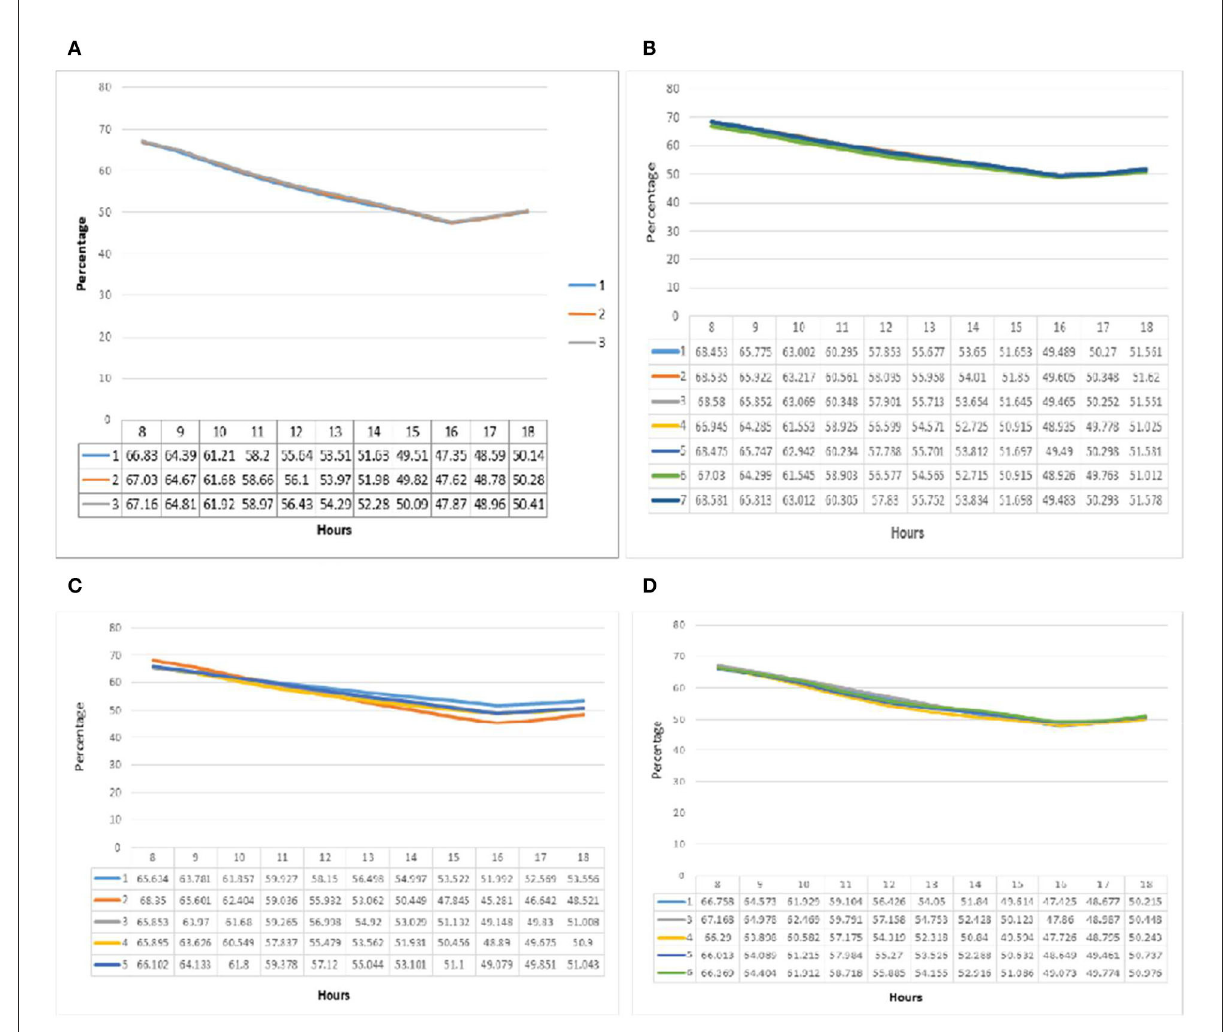
FIGURE4 (A–D) Relative humidity comparison diagrams from point A in all groups,